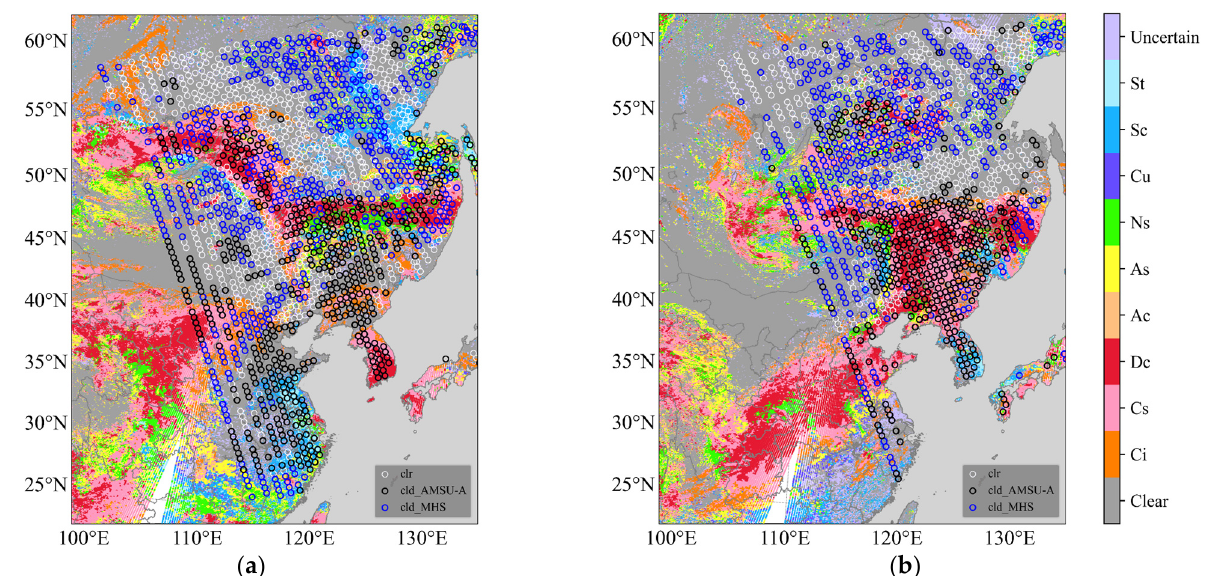
Figure 7. Clear-sky FOVs (white circles) and cloudy FOVs detected by the AMSU-A cloud index (black circles) and MHS cloud index (blue circles), along with the matched MODIS cloud classification products at the same moment, at ( a ) 0600 UTC 26 June and ( b ) 0600 UTC 28 June 2019.